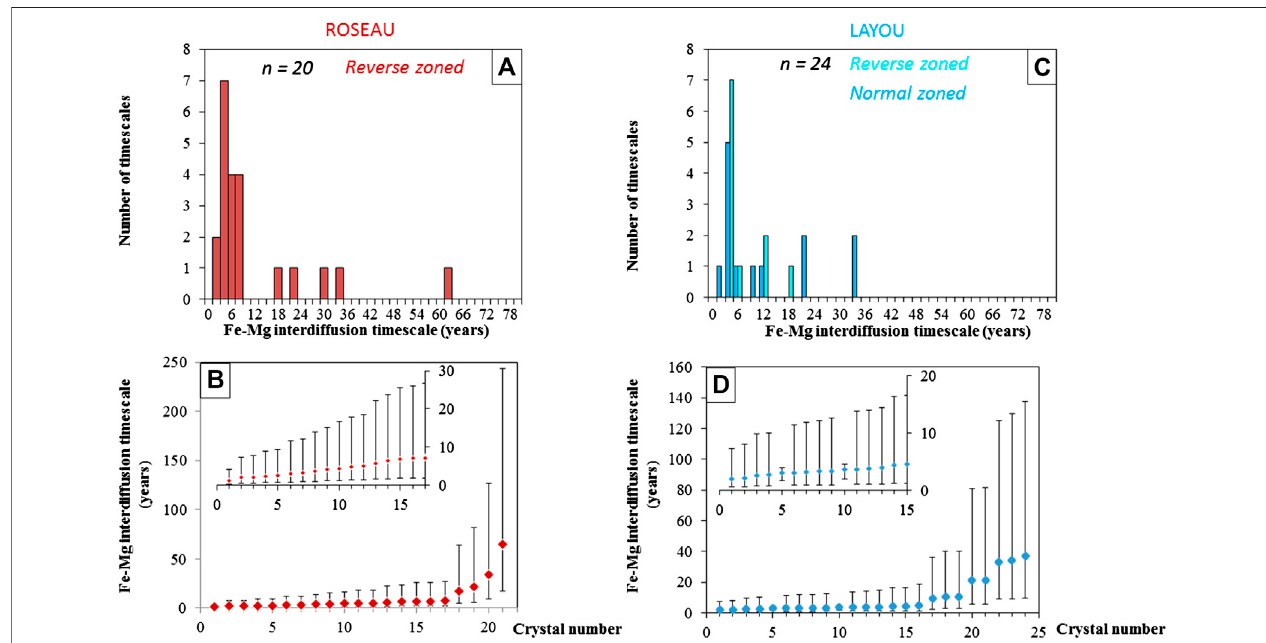
FIGURE6| TimescaleestimatefromFe-Mginterdiffusionmodellinginorthopyroxenes.Frequency histogramofFe-Mginterdiffusiontimescalesmodelledat850 ° C for the main core-rim boundary of (A) Roseau opx and (C) Layou opx; (B) and (D) individual ages and their absolute uncertainties based on the propagation of a temperature uncertainty of ± 25 ° C for (B) Roseau and (D) Layou. The inset graphs inside (B) and (D) represent selected individual ages from the peak in interdiffusion ages.